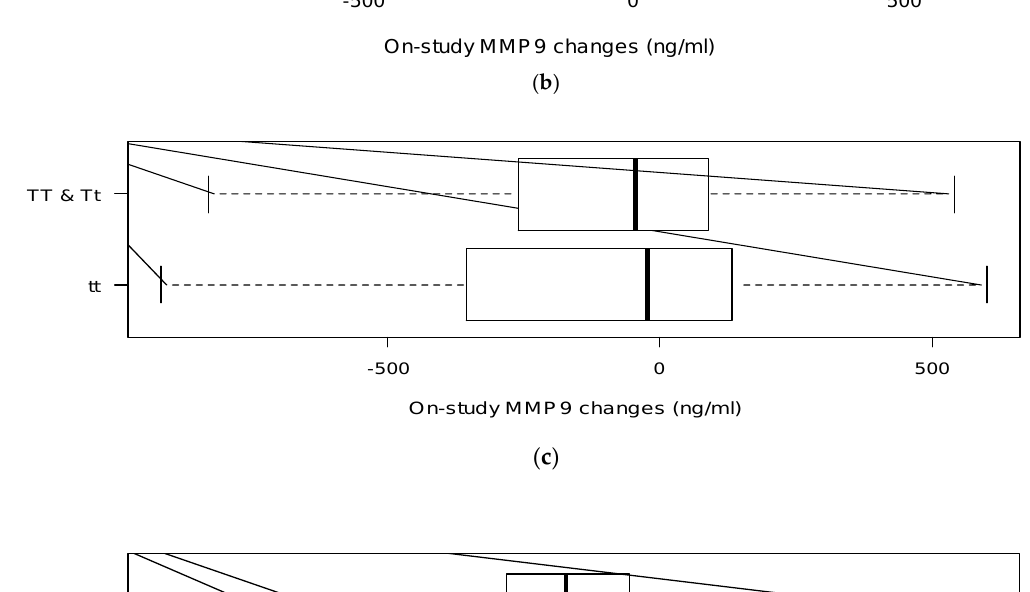
(4000 IU / day for 12 weeks) across the VDR polymorphic groups. ( a ) Matrix metallopeptidase 9 (MMP9) supplementation (4000 IU/day for 12 weeks) across the VDR polymorphic groups. ( a ) Matrix